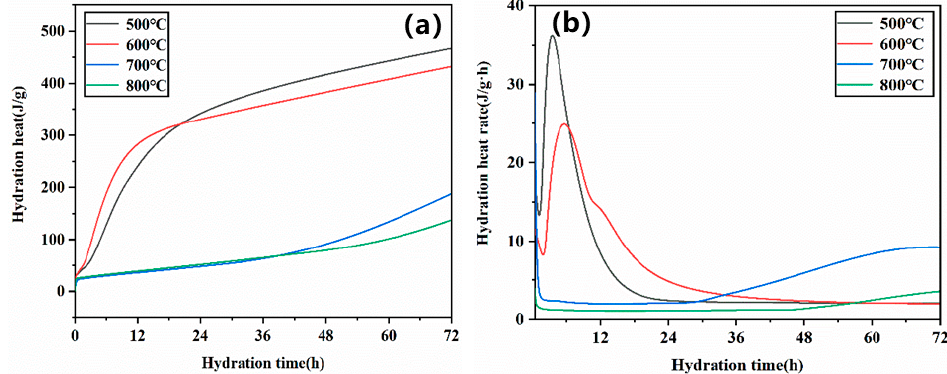
Figure 9. Hydration exothermic curves of different type of MOC cement: ( a ) Hydration heat ( b ) Hydration reaction rate.